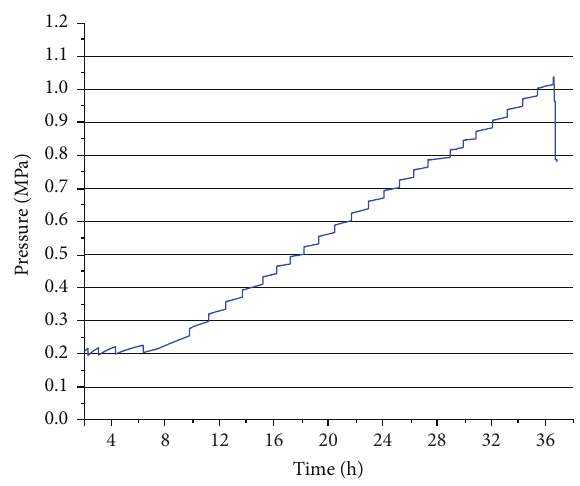
Figure 7: Numerical result of air pressure for the second accident.